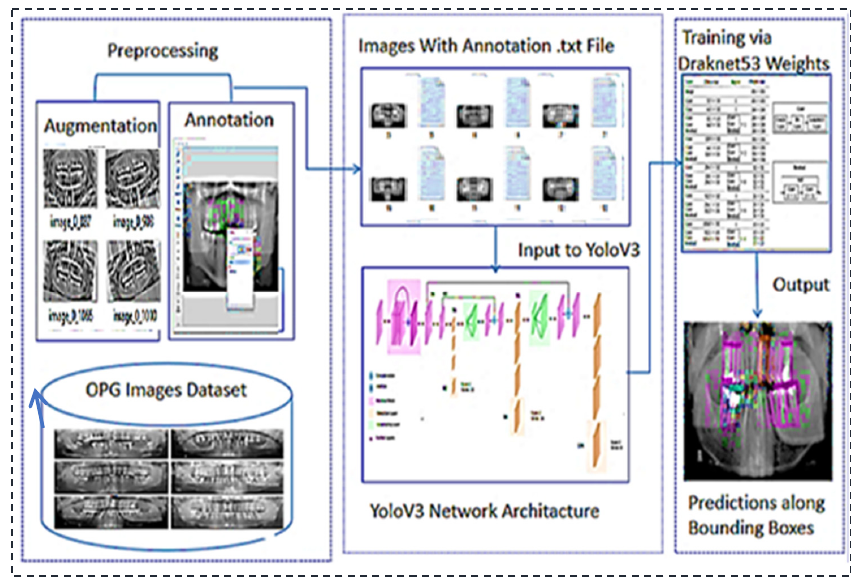
Figure 1. Proposed architecture’s workflow for the teeth diseases classification.